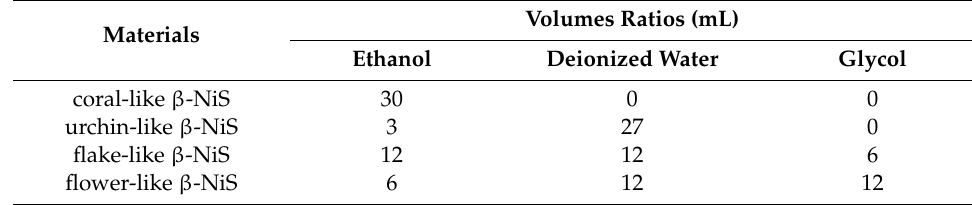
Table 1. Solvent volume ratios for β -NiS with coral-like, urchin-like, flake-like, and flower-like morphologies. Volumes Ratios (mL) Materials Ethanol Deionized Water